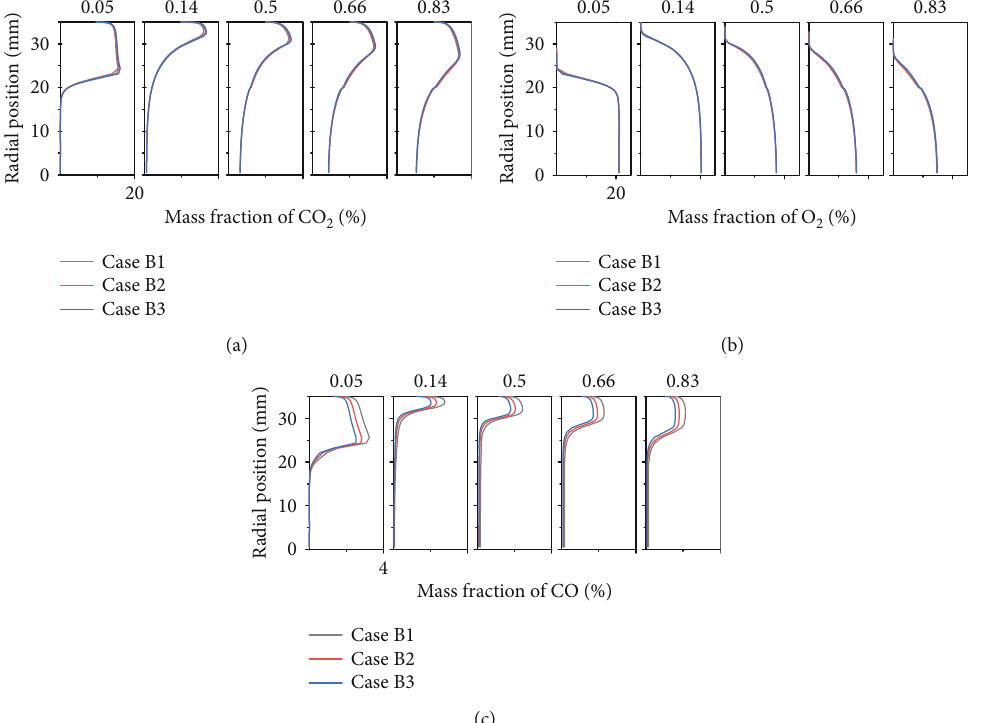
Figure 18: Radial pro fi les of the mass fraction of CO